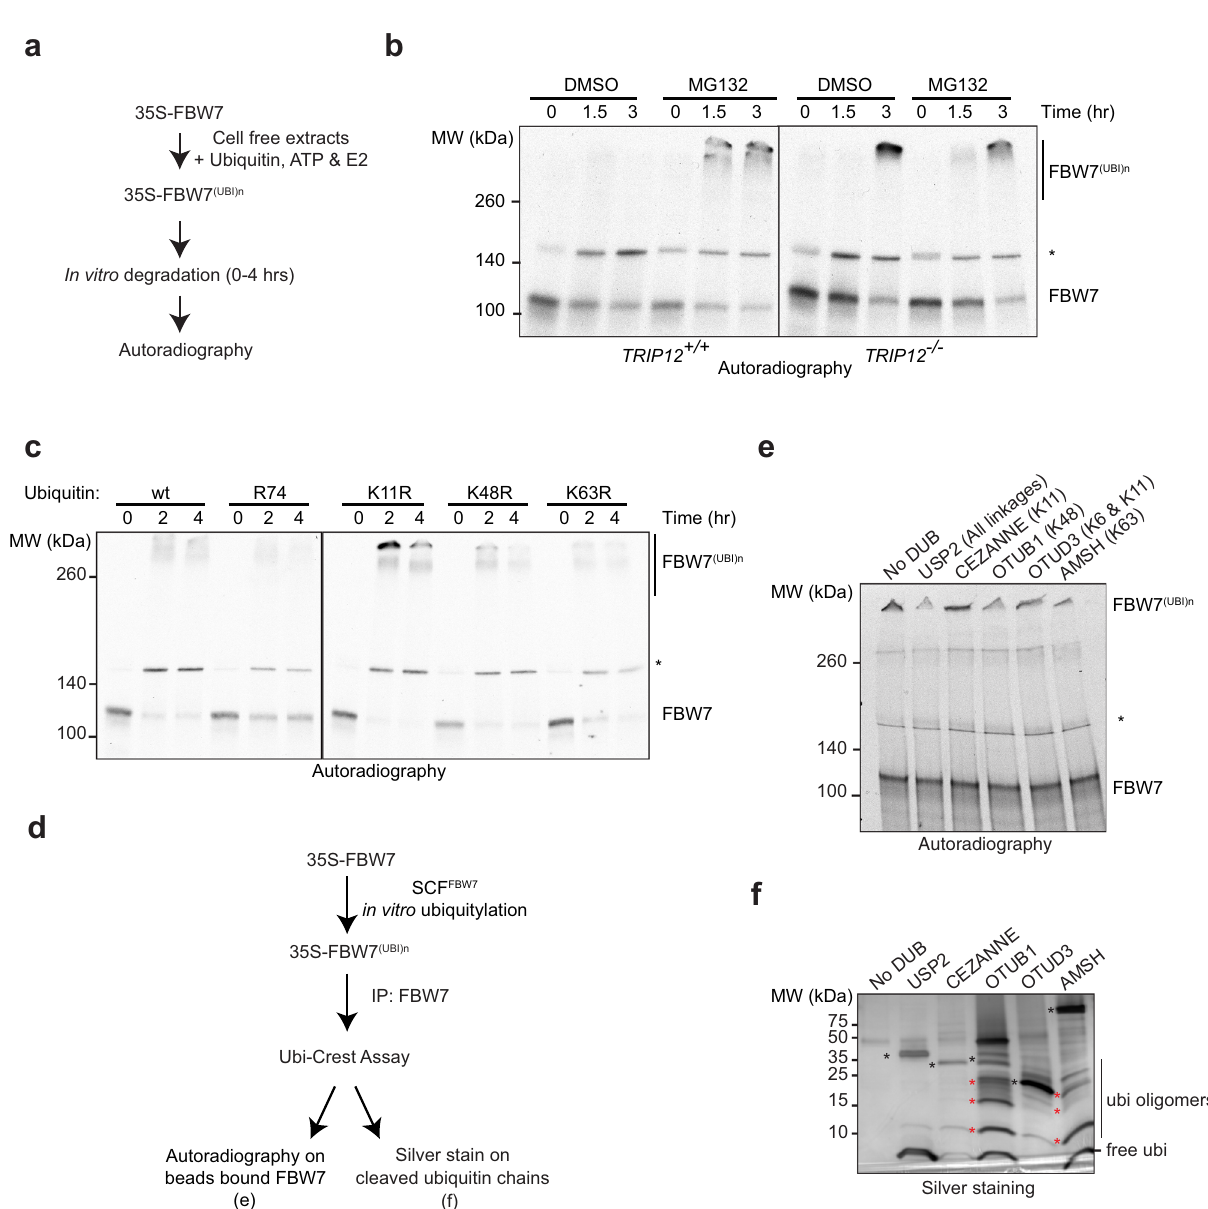
Fig. 6 TRIP12-mediated K11-linked ubiquitylation is essential for FBW7 proteasomal degradation. a Schematic of in vitro degradation assay. b In vitro 35S-FBW7 α degradation assay performed in cell-free extracts from cells of the indicated genotypes and visualised by autoradiography. c In vitro FBW7 degradation assay performed in cell-free extracts in the presence of the indicated ubiquitin mutants and visualised by autoradiography. d Schematic for in vitro ubiquitylation and ubiquitin restriction enzyme digest experiment for 35S-FBW7. e Autoradiographs showing cleavage of beads-bound polyubiquitylated 35S-FBW7 by the indicated DUBs. Linkage speci fi city is given in parentheses. Black stars (*) in b , c , and e represent the nonspeci fi c band of unknown identity. f Silver stain on cleaved ubiquitins in the supernatant from the experiment in e , black stars represent respective DUBs and red stars label uncleaved ubiquitin oligomers. All blots are representative of at least three independent experiments with the exception of e , which was done twice with similar results. Source data are provided as a Source Data fi